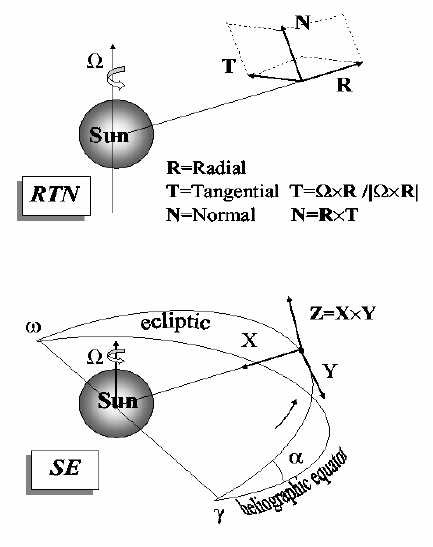
Figure 118: The top reference system is the RTN while the one at the bottom is the Solar Ecliptic reference system. This last one is shown in the configuration used for Helios magnetic field data, with the 𝑋 -axis positive towards the